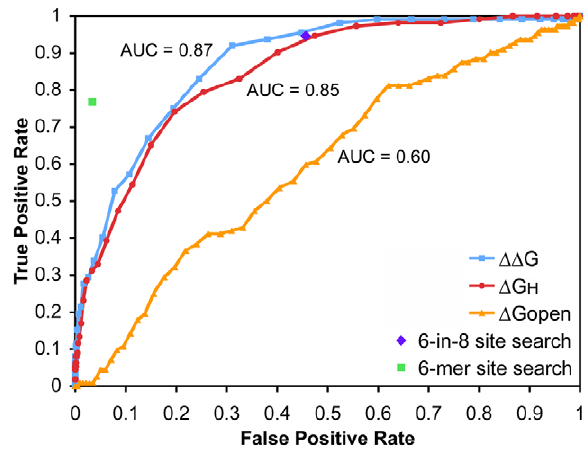
Figure 2. Contribution of energy values at Tarbase sites vs control sites. The plot shows ROC curves and corresponding AUC values for the three energy types in the duplex formation steps: DD G, D G H , and D G open . The result for a canonical 6-mer seed match search and a search for relaxed seeds (at least 6 out of 8 positions—a 6-in-8 filter) are also shown.